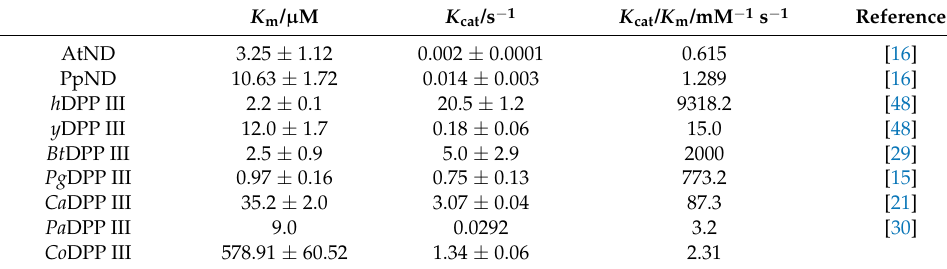
Table 1. Kinetic parameters of the reported DPP III.